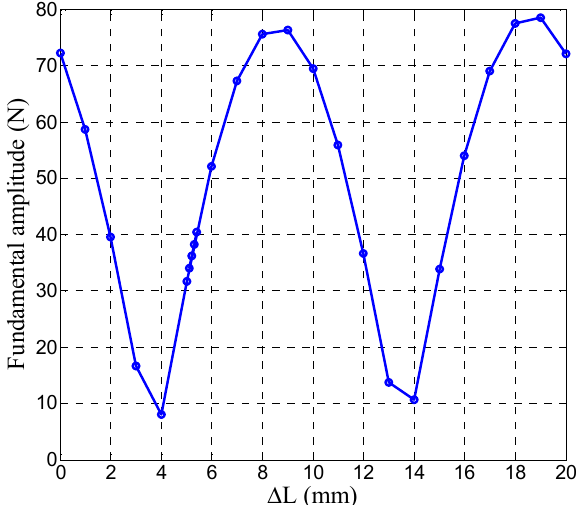
Figure 5. End-effect cogging force vs. mover displacement and Δ L . ( a ) 3-D view; ( b ) 2-D view.